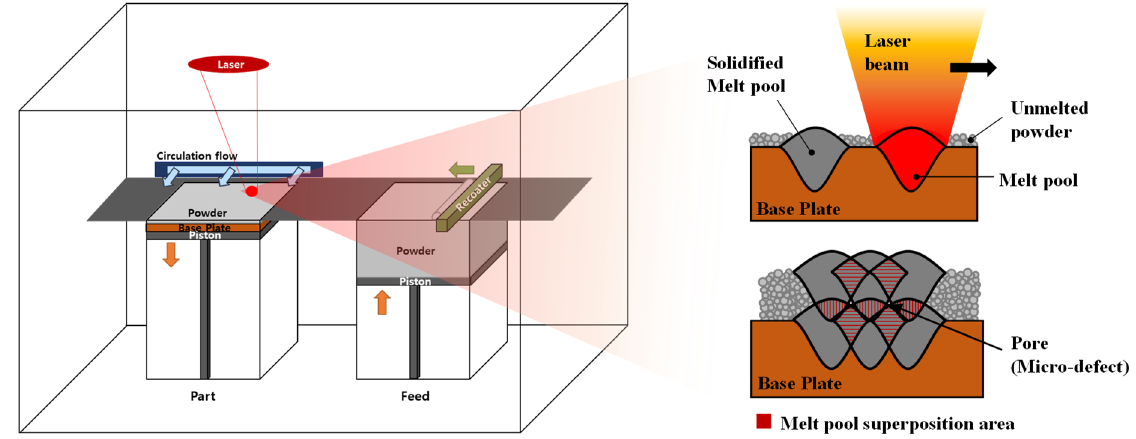
Figure 1. Schematic diagram of laser powder bed fusion (LPBF) process.